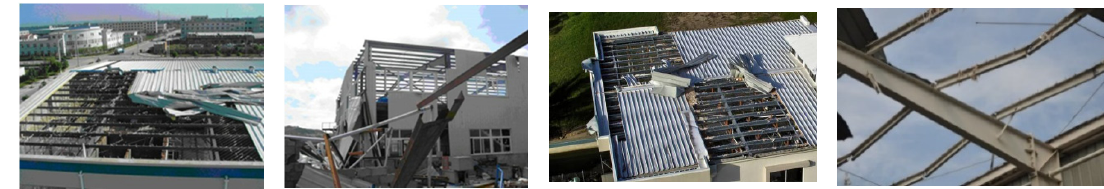
Figure 1. Failure of cladding ‐ fastener connections.